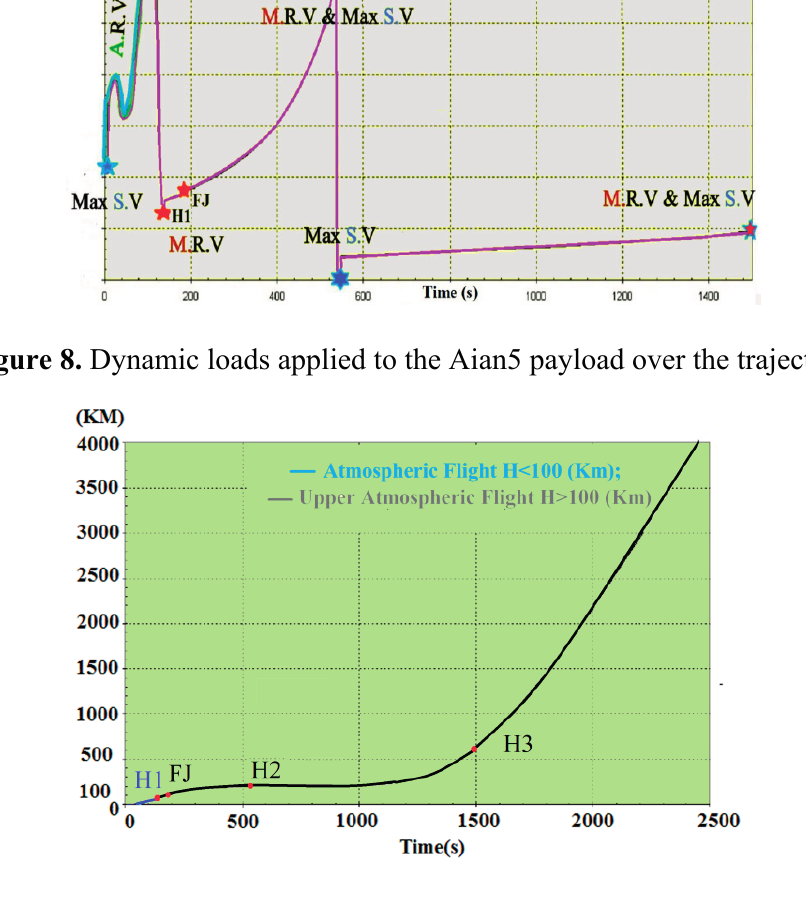
Figure 9. Arian 5 sequences of events during atmospheric and upper atmospheric flight, adapted from